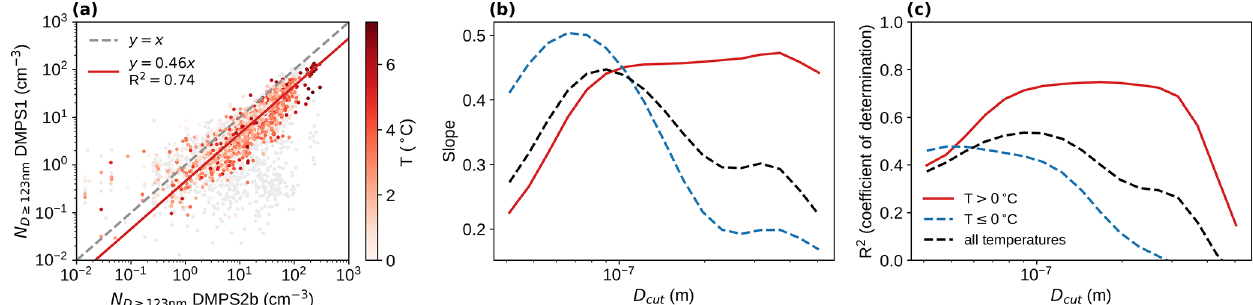
Figure 4. Comparison of total and residual accumulation mode particle concentrations. (a) Scatterplot of accumulation mode (here diameter > 123nm) concentrations from DMPS2b and DMPS1 for temperatures > 0 ◦ C, together with an ODR best fit slope. Temperatures ≤ 0 ◦ C are shown as grey points but are not included in the fit. Panels (b) and (c) show ODR best fit slopes and corresponding coefficients of determination, respectively, for different lower boundaries ( D cut ) of the accumulation mode. The red lines show these parameters for temperatures > 0 ◦ C, and the dashed lines show the corresponding values for temperatures ≤ 0 ◦ C (blue) and all data (black), included for completeness. The 30min mean values of DMPS1 and DMPS2b data were used for this